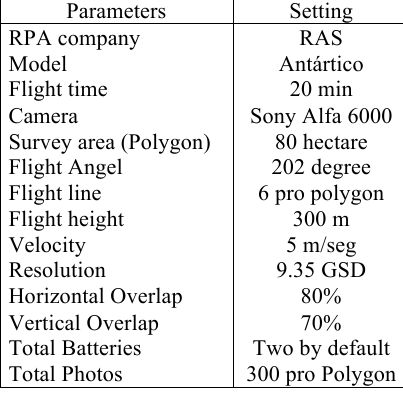
Table 1 : Photogrametrics parameters of the